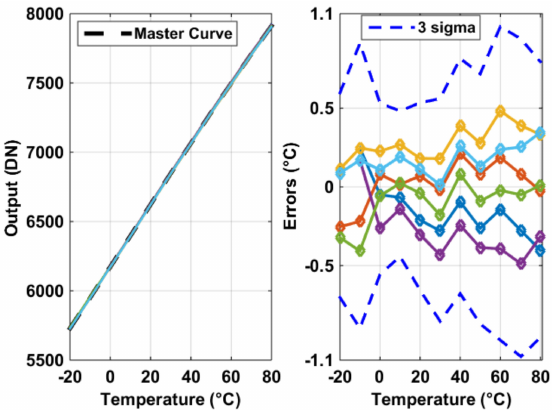
Figure 12. Measurement results of the six incorporated BJT-based temperature sensors inside the pixel ( left ) and their untrimmed errors, with 3 σ inaccuracies, upon a global 2nd order curve fitting ( right ).